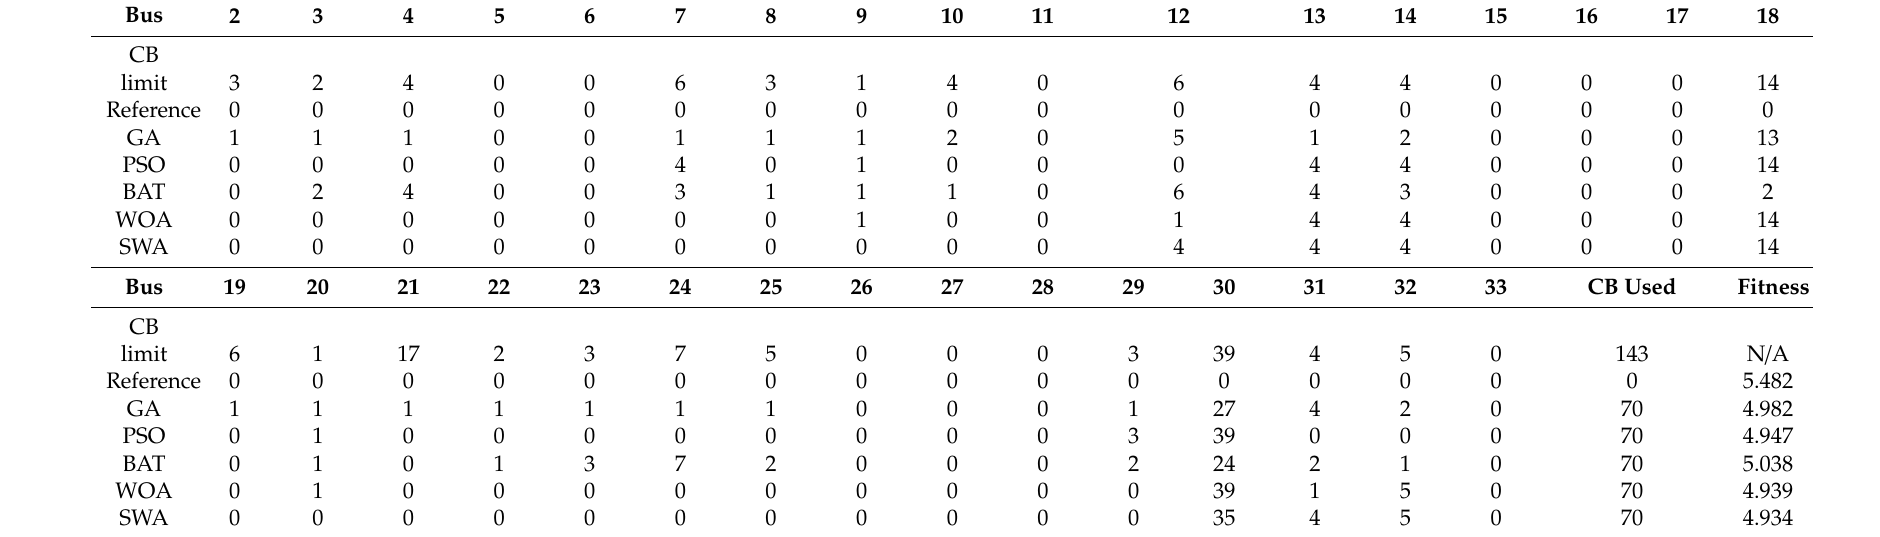
Table 7. The OCBA solutions found by the metaheuristic algorithms for the IEEE 33-bus